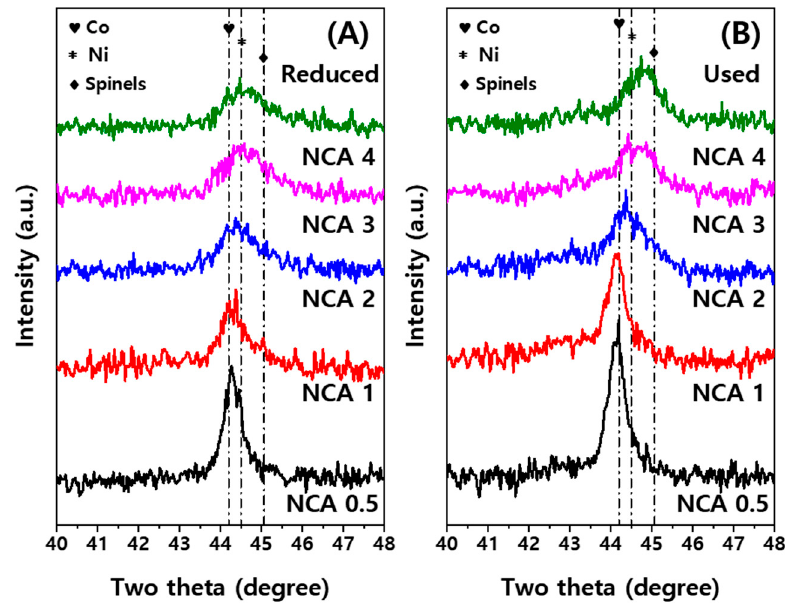
Figure 1. X-ray diffraction patterns of the ( A ) reduced and ( B ) used NCA catalysts. Figure 1. X-ray di ff raction patterns of the ( A ) reduced and ( B ) used NCA